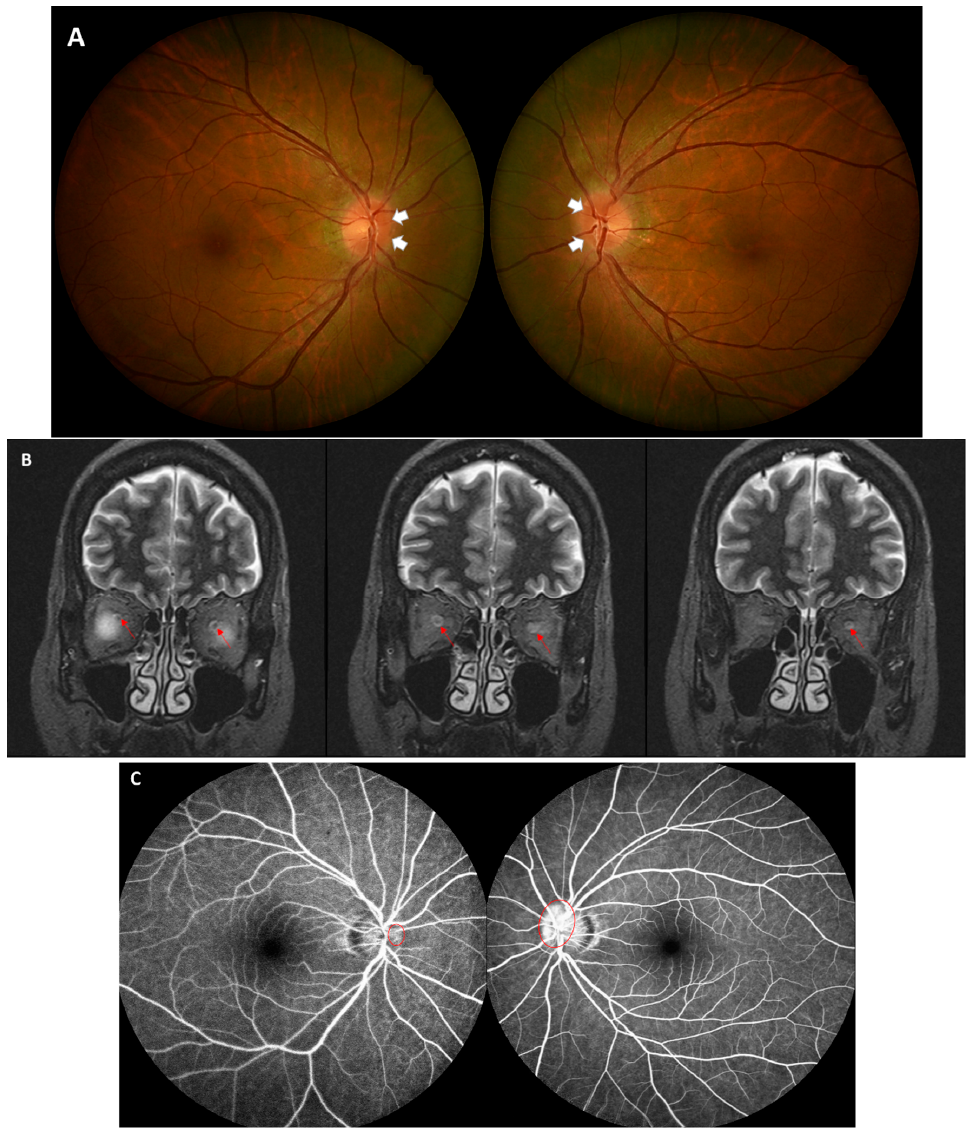
Figure 1. ( A ) Fundus color photography revealed bilateral disc edema (white arrows), with the left side more prominent. ( B ) Coronal T2-weighted images of the orbits showing T2 magnetic resonance image in the bilateral optic nerves, more profound on the left side (red arrows). ( C ) Fluorescein angiography showed late phase dye leakage (red circles), confirming disc edema without vessel abnormalities.